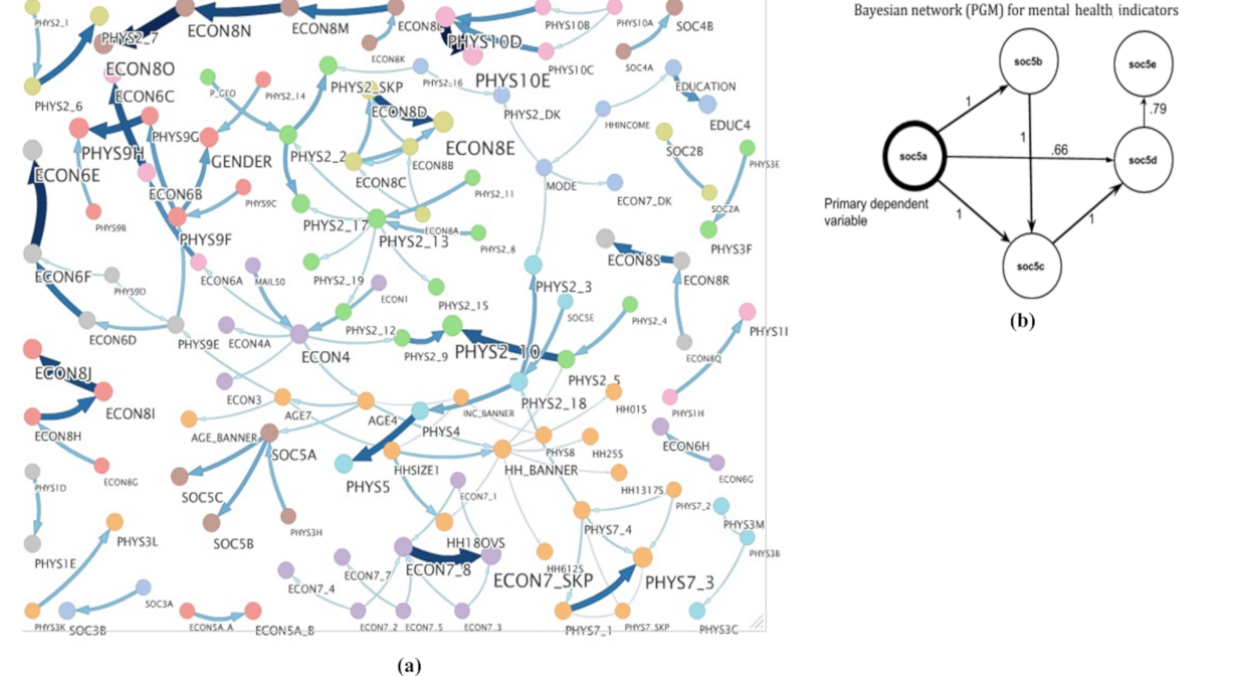
Figure 4. (a) Consensus structure learned through 101 bootstrapped samples. Hill climbing search along with Bayesian information criterion was used to learn the structures and connections having edge strength and direction strength more than 90% are shown. The color of the edges represents the proportion of networks in which that edge was present in the 101 bootstrapped samples, an indicator of confidence; (b) attribute soc5a was found to be the parent node of all other mental health variables, therefore, leading to our choice of this variable as the primary dependent variable. PGM: probabilistic graphical